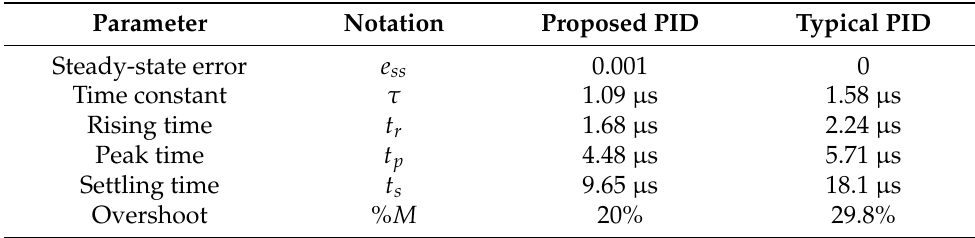
Table 5. Closed-loop step response performance parameters for the minimum phase part of the boost converter (7).